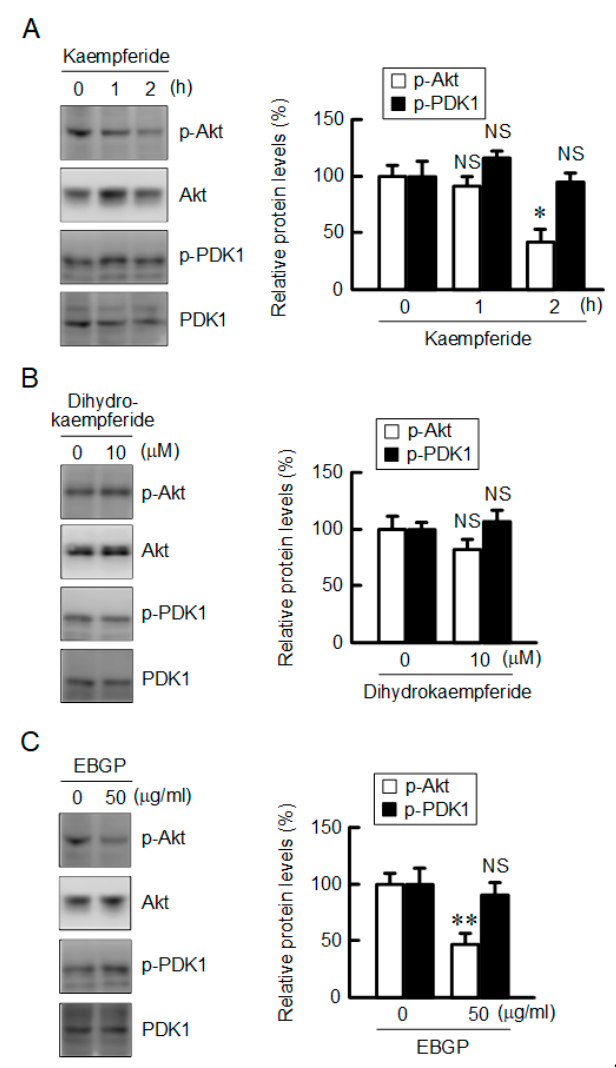
Figure 6. Inhibition of phosphorylation of Akt by EBGP and kaempferide. Cells were incubated with 10 µ M kaempferide for 0, 1, and 2 h ( A ), or 10 µ M dihydrokaempferide ( B ) and 50 µ g / mL EBGP for 2 h ( C ). The protein levels of p-Akt, Akt, p-PDK1, and PDK1 were examined by Western blotting and represented as a percentage relative to 0 h, 0 µ M, or 0 µ g / mL. n = 3–4. ** p < 0.01, * p < 0.05, and NS p > 0.05 compared with 0 h (one-way analysis), 0 µ M, or 0 µ g / mL (Student’s t test). Time course (F 3,6 = 10.47, p = 0.01106).